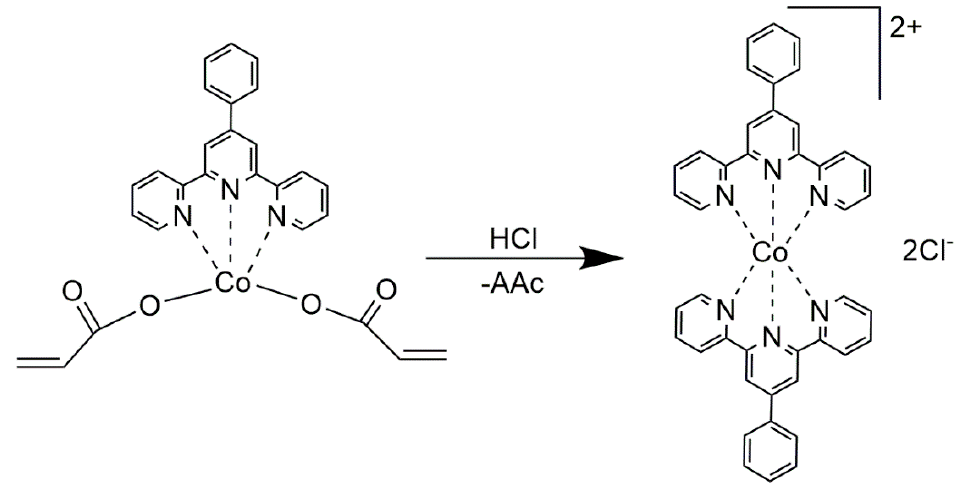
Figure 12. Reaction of CoAcr 2 PhTpy with HCl: 1—initial complex, 2—addition of 1 drop of HCl, 3— addition of 2 drops of